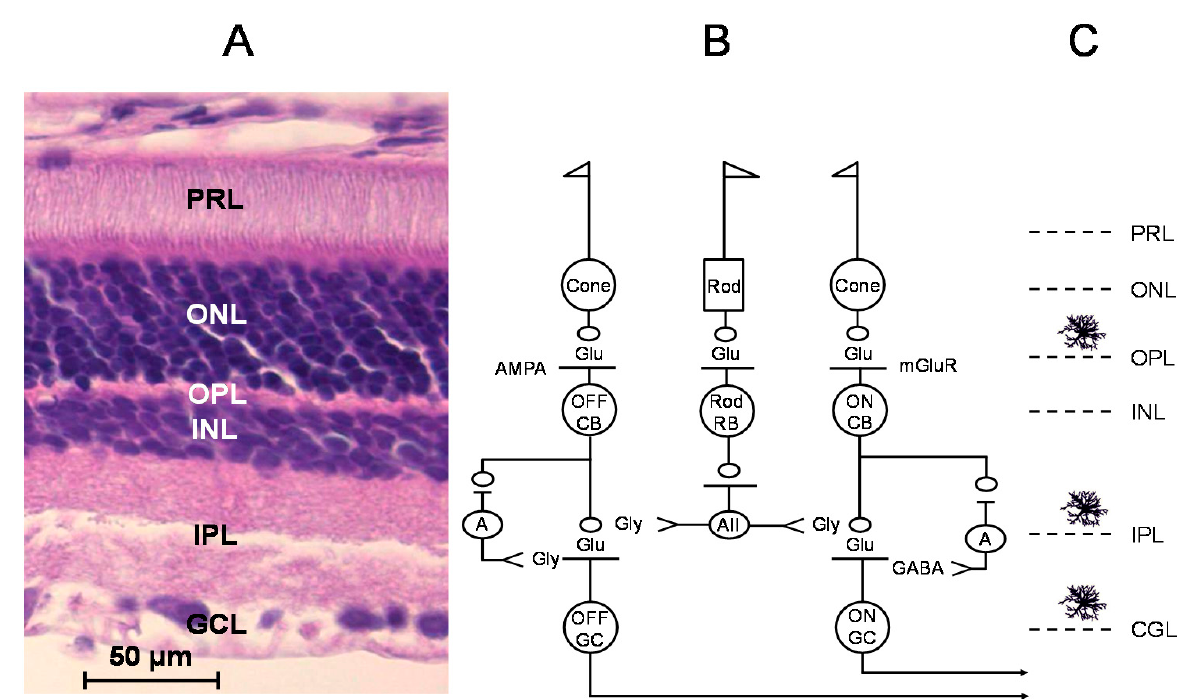
Figure 1. ( A ) Cytoarchitecture of the retina. Vertical section of rat retina stained with hematoxylin-eosine (made with the courtesy of Dr. Mihaly Albert). ( B ) Neural circuitry of the retina. Cone bipolar (CB) axons descend to the inner plexiform layer; the two categories of bipolar cells terminate at different levels: Axons of the OFF bipolar cells send axons to the upper part of the inner plexiform layer and the ON bipolar cells end in the lower part. Rod bipolar (RB) cells release glutamate and synapse to AII amacrine cells. Glycinergic AII cells append to OFF bipolar terminals and OFF ganglion cell dendrites in the upper level of the inner plexiform layer and these interneurons also synapse to ON cone bipolar cells in the lower half of the inner plexiform layer. Retinal ganglion cells receive excitatory glutamatergic innervation from cone bipolar cells and inhibitory influence from amacrine cells. About half of the amacrine cells are glycinergic and the other half is GABAergic. The OFF pathway is under the direct control of glycine released from glycinergic amacrine cells, whereas the ON pathway is under the inhibition of GABAergic amacrine cells. NR1/NR2A-type NMDA receptors are present in the synapses formed between bipolar and ganglion cells, whereas extrasynaptic NR1/NR2B-type NMDA receptors are predominantly expressed in ON ganglion cells. Thus, the primary target for excitotoxicity is the ON ganglion cells in the retina. ( C ) Microglial cells in normal retina are mainly distributed in the outer and inner plexiform layers. In the glaucomatous retina, microglia are present in the ganglion cell layer surrounding the retinal ganglion cell axons and soma. In the diabetic retina, perivascular accumulation of activated microglia cells can be found. These cells are accumulated in the outer nuclear layer and subretinal space in age-related macular degeneration [7,10,11]. PRL, photoreceptor layer; ONL, outer nuclear layer; OPL, outer plexiform layer; INL, inner nuclear layer; IPL, inner plexiform layer; GCL, ganglion cell layer; A, amacrine cell; AII, AII glycinergic interneuron; AMPA, AMPA receptor; mGluR, metabotropic glutamate receptor; CB, cone bipolar cell; RB, rod bipolar cell; GC, ganglion